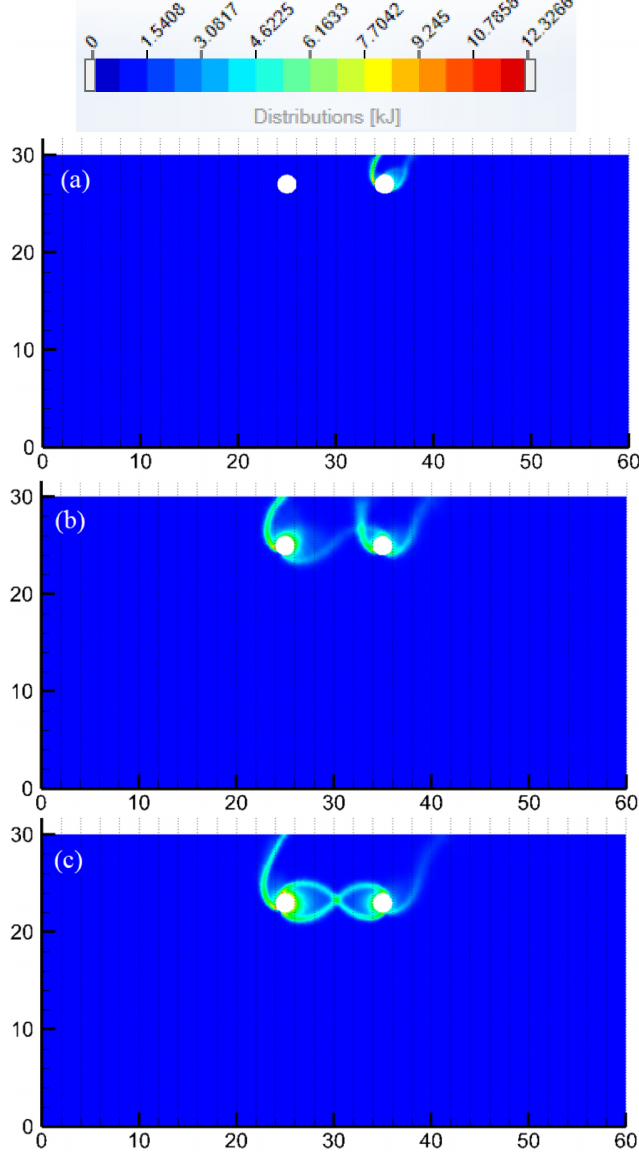
Figure 10. Upper bound failure mechanisms with S / D = 3, γ D / c = 1, k h = 0.1 and ϕ = 10 ◦